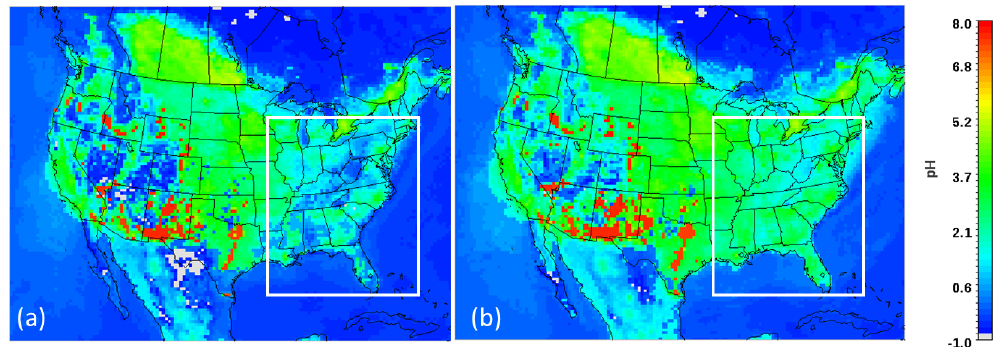
Figure 1. Annual averaged PM 2 . 5 pH over CONUS for (a) 2001 and (b) 2011, calculated offline using ISORROPIA II and the annual averaged CMAQ concentration fields. The white outline specifies the eastern US domain used for further